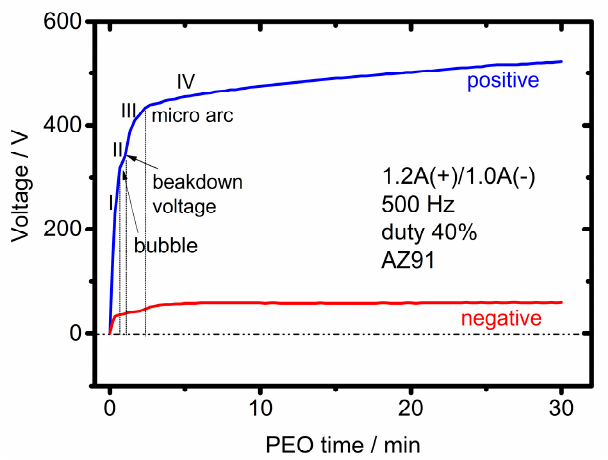
Figure 1. Typical voltage–time curves of PEO with a pulsed bipolar current at 500 Hz. Reprinted with permission from [18]; Copyright 2015 Elsevier. The experiment has been performed on an AZ91 plate sample of surface area 27.5 cm 2 with 5 g · dm − 3 Na 2 SiO 3 , 1 g · dm − 3 Na 2 B 4 O 7 , 1.5 g · dm − 3 KOH in electrolytic solution. Data are plotted as the absolute values of voltage.